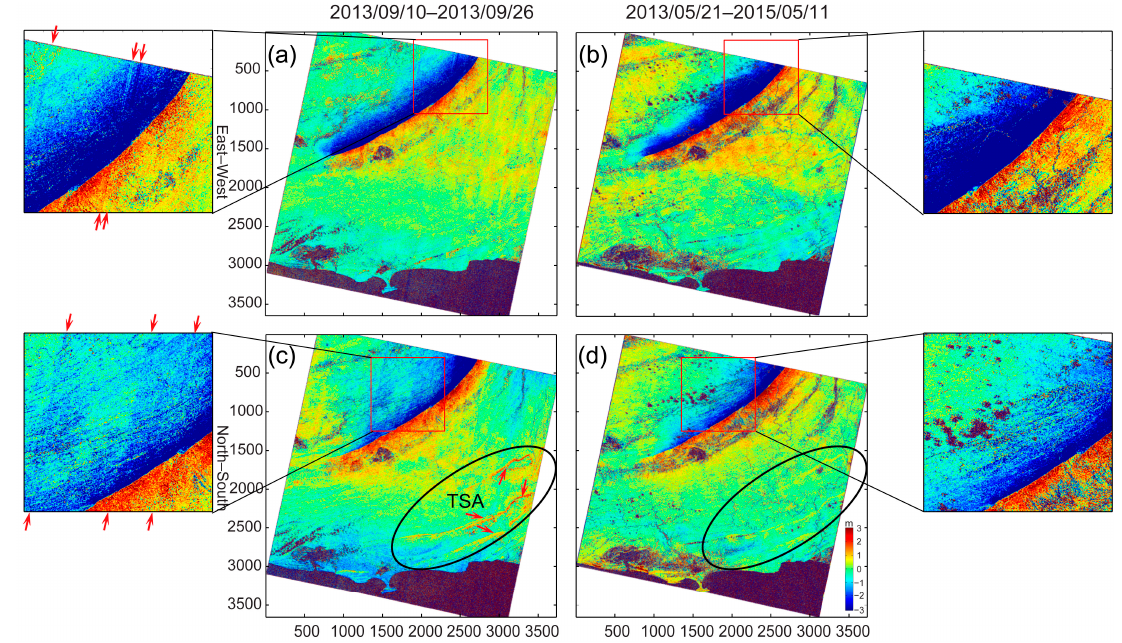
Figure 7. Comparison between the “mean subtracting” method and small spatial baseline method in terms of the SA reduction: ( a , b ) the E/W components of 10–26 September 2013 using the “mean subtracting” method and 21 May 2013–11 May 2015 using the small spatial baseline method; and ( c , d ) the N/S components of 10–26 September 2013 using the “mean subtracting” method and 21 May 2013–11 May 2015 using the small spatial baseline method. This comparison further demonstrates that the magnitude level of SA has a strong correlation with spatial baseline of the correlated image pair. In addition, the ellipse lines circle the topography-dependent artifacts area, in which the red arrows in ( c ) indicate the specific locations.